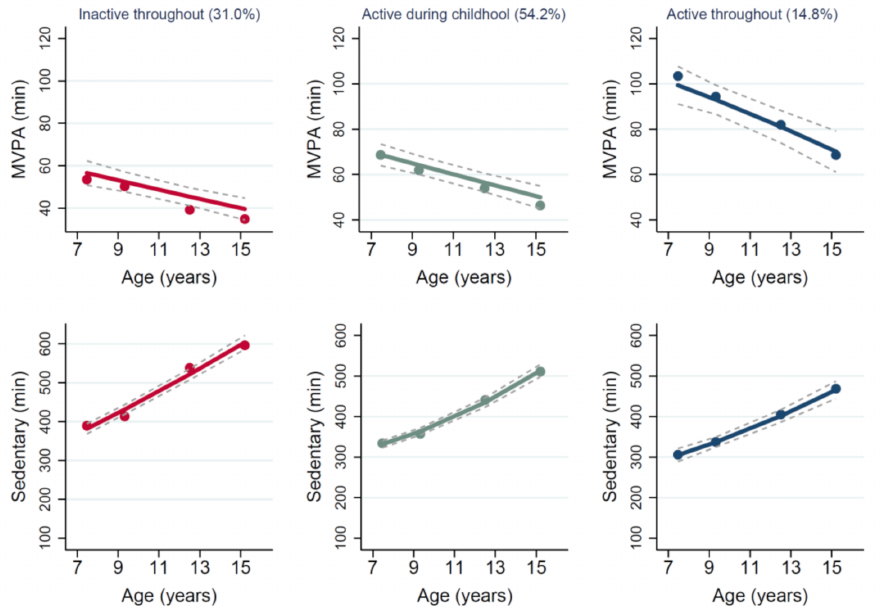
Figure 3. Multiple trajectories of average time spent in moderate-vigorous-intensity physical activity (MVPA) and sedentary behaviour (minutes per day). Dots indicate observed average MVPA and sedentary behaviour (minutes/day), and solid lines are trajectories showing estimated mean time spent in MVPA and sedentary behaviour (minutes/day) across age for the three groups identified. The grey dashed lines represent the 95% confidence intervals for each